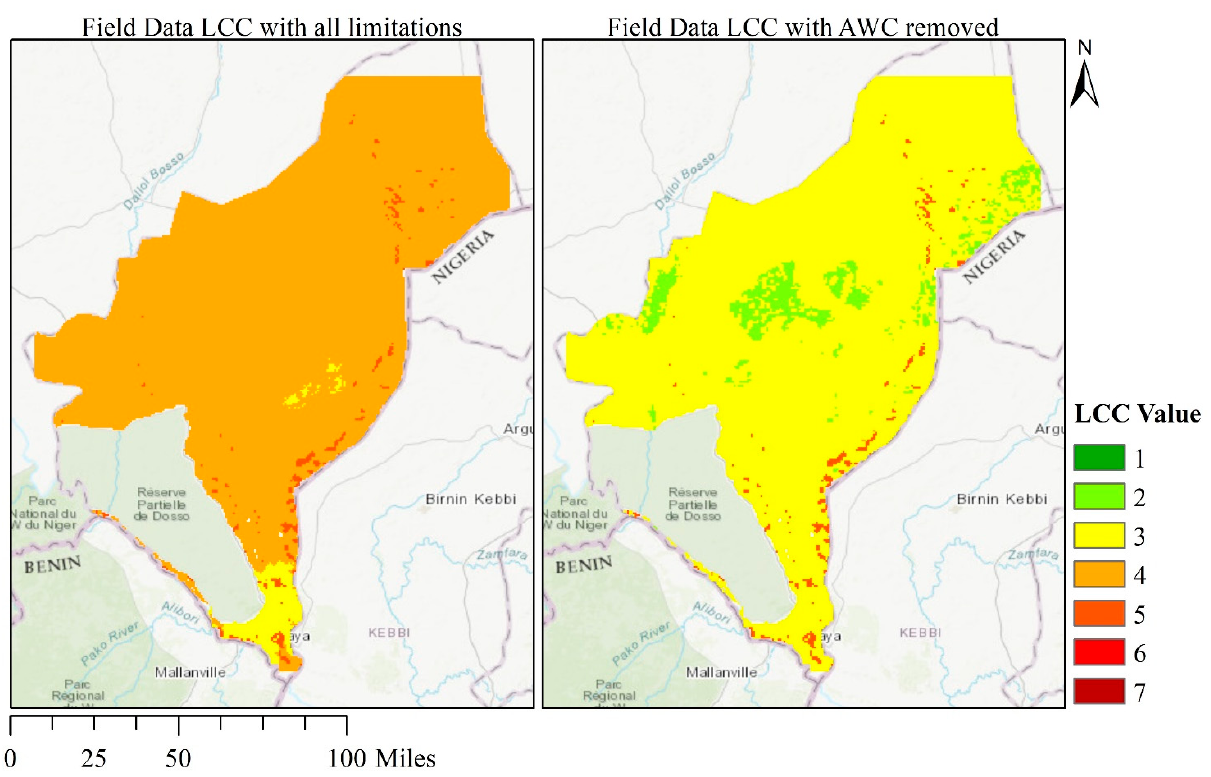
Figure 3. LCC mapping of field data with and without AWC as a limitation. Table 7. Land capability classification breakdown with all limitations considered—Field